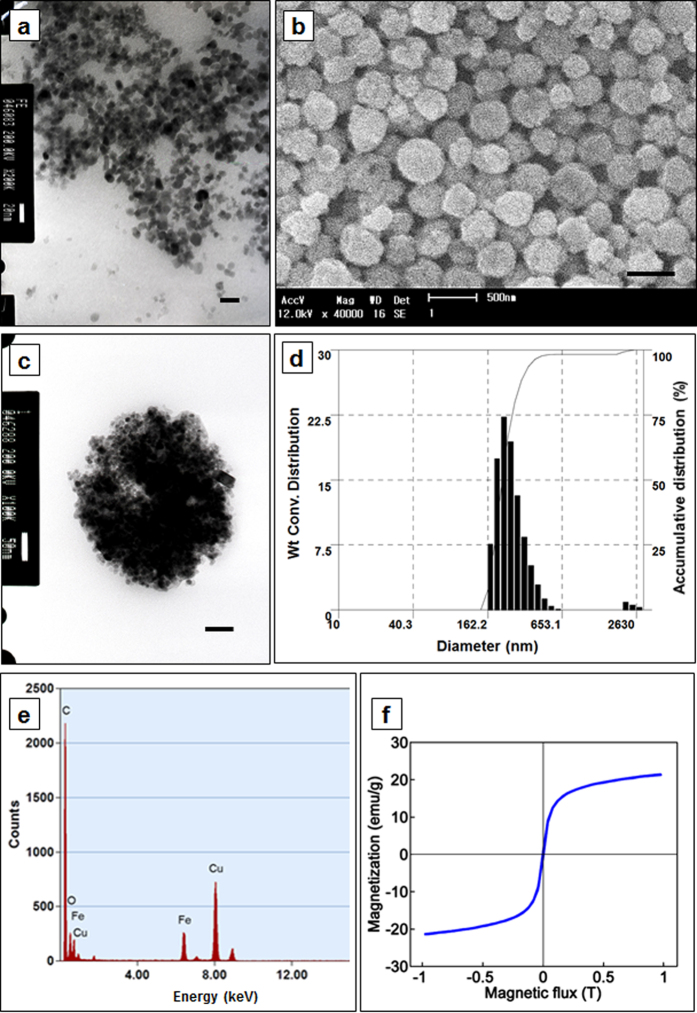
Microscopy images of PLGA-DTX-Fe3O4 nanoparticles.(a) TEM image of MNP nanoparticles, their size was 7–8 nm in diameter. (b,c) SEM, TEM images of PLGA-DTX- Fe3O4 NPs, and (d) Size distribution of PLGA-DTX-Fe3O4 NPs; average size, 300 nm in diameter, (e) EDX elementary analysis for identification of Fe distribution in PLGA-DTX- Fe3O4 NPs. (f) Magnetization curve of the PLGA-DTX-Fe3O4 NPs.